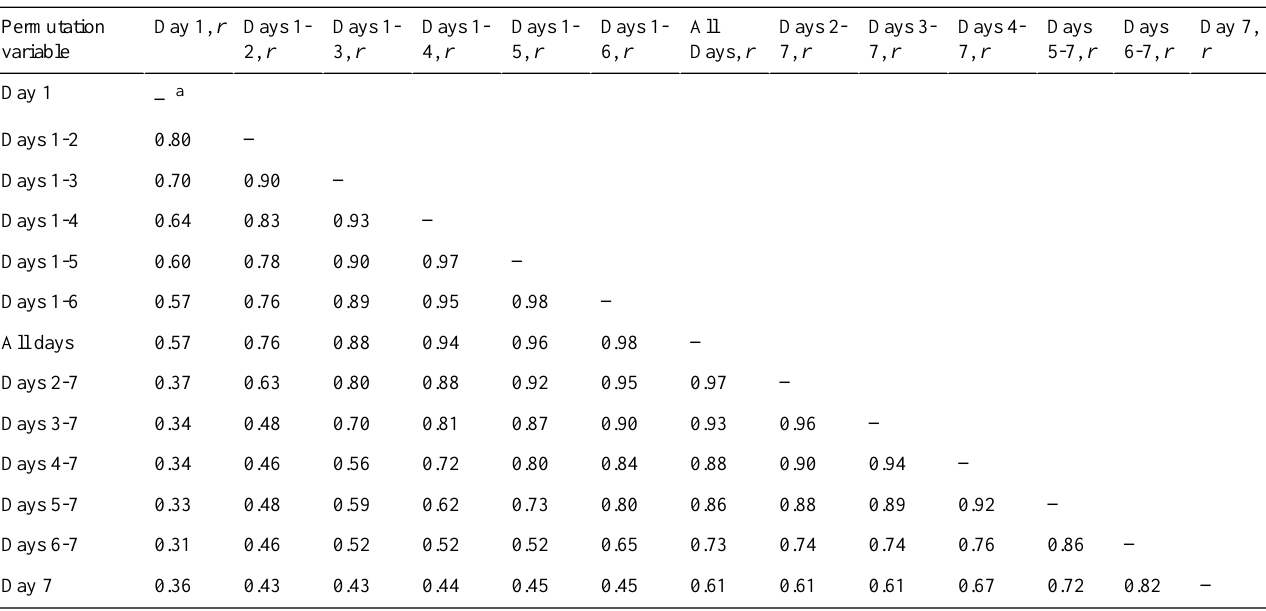
Table 2. Family meal healthfulness permutation measures with pairwise Pearson correlations. Correlation coefficients r are all significant at P